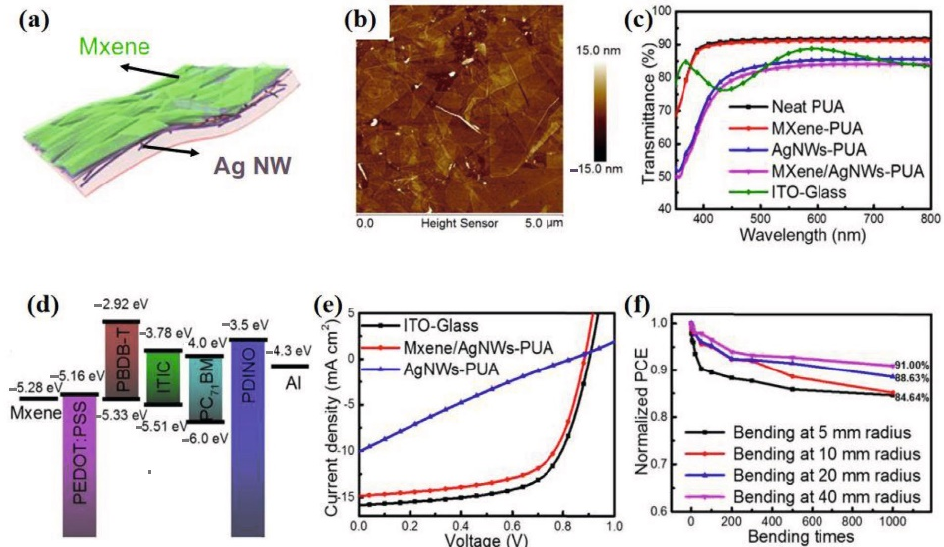
Figure 6. ( a ) Schematic representation of the MXene/AgNW hybrid electrodes on PUA substrates. ( b ) AFM images of the MXene/AgNW PUA films. ( c ) Transmission spectra of pure PUA, MXene- PUA, Ag NW-PUA, optimised MXene/Ag NW-PUA, and ITO glass. ( d ) Energy level diagrams of the flexible OSCs. ( e ) JV curves of the flexible OSCs with PBDB-T: ITIC: PC71BM active layers. ( f ) Normalised PCE of the flexible OSCs with MXene/Ag NW electrodes as a function of the number of bending cycles. Reproduced with permission. Reprinted with permission from ref. [116,117]. Copy- right 2019 American Chemical Society.